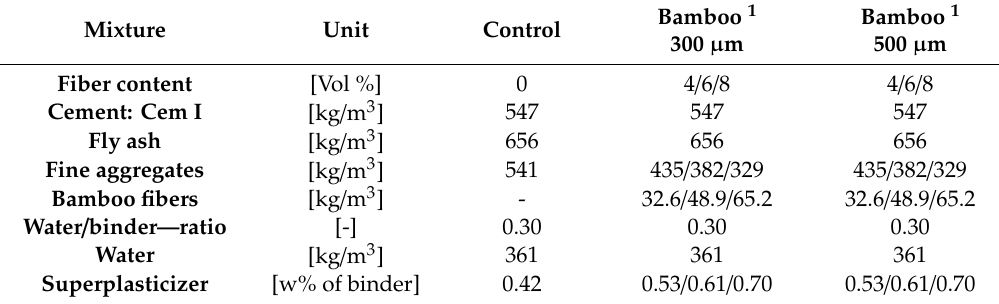
Figure 2. Particle size distribution of the fine aggregates used in this study.